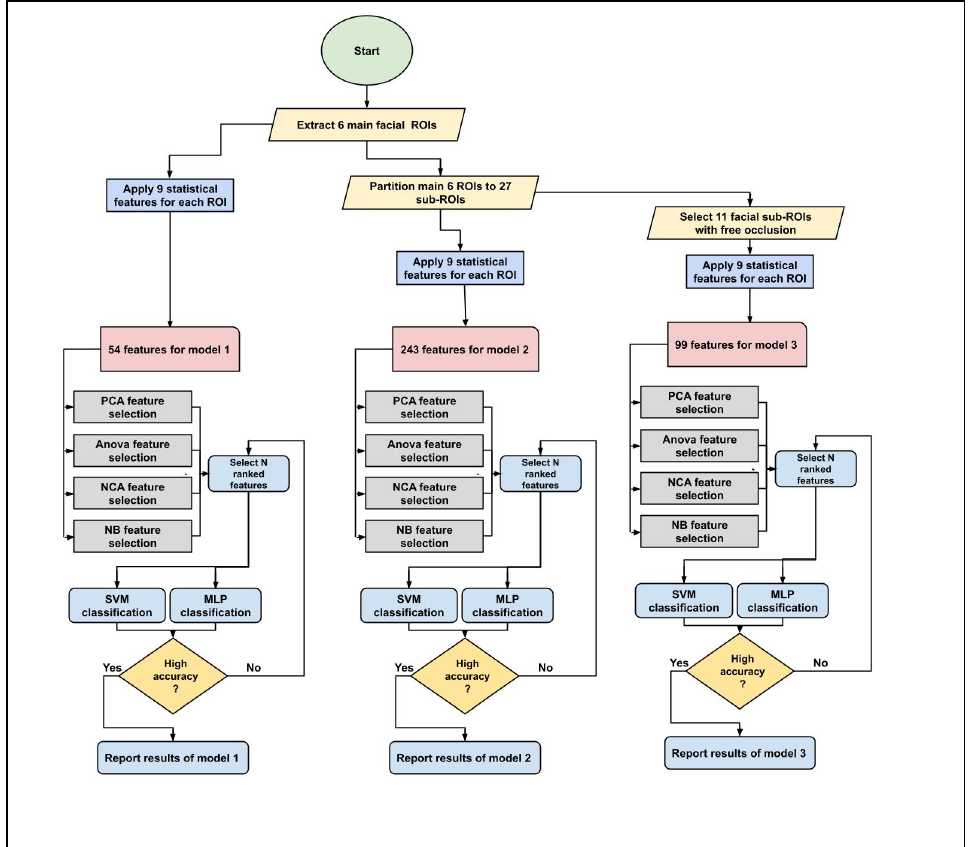
Figure 4. Classi fi cation process fl ow with multiple feature selection and classi fi cation algorithms. Figure 4. Classification process flow with multiple feature selection and classification algorithms. Table 1. Mean accuracy results for affective state recognition based on six main ROIs reported from the implementation of SVM and MLP classifiers with PCA, ANOVA, NCA, and NB feature selection